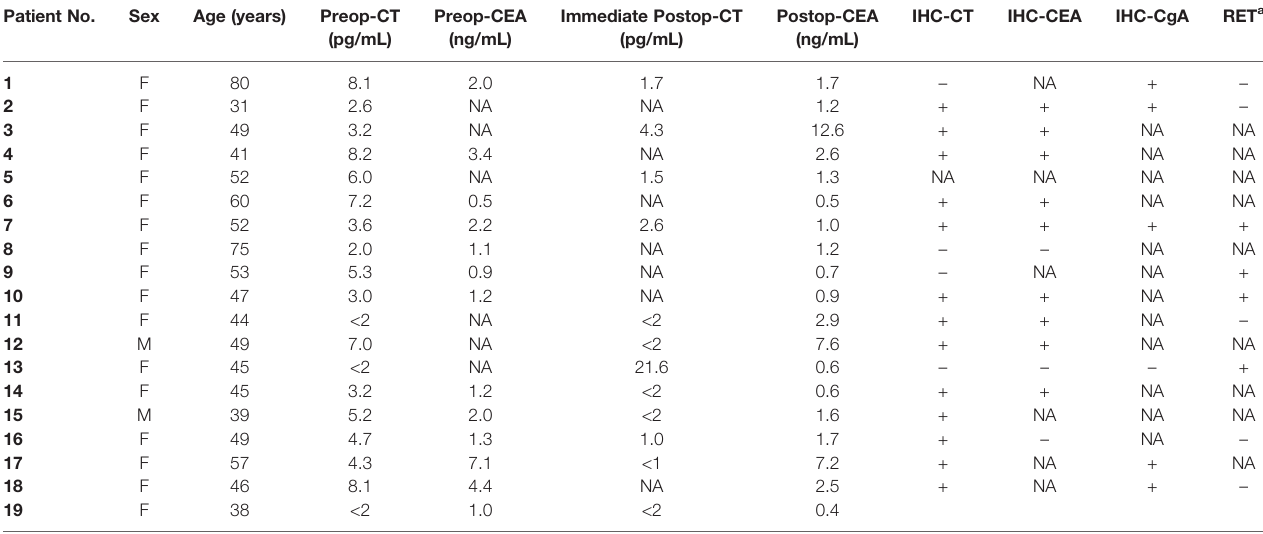
TABLE 2 | Perioperative serum calcitonin and CEA level and histopathologic fi ndings of calcitonin-negative medullary thyroid carcinoma. Patient No.